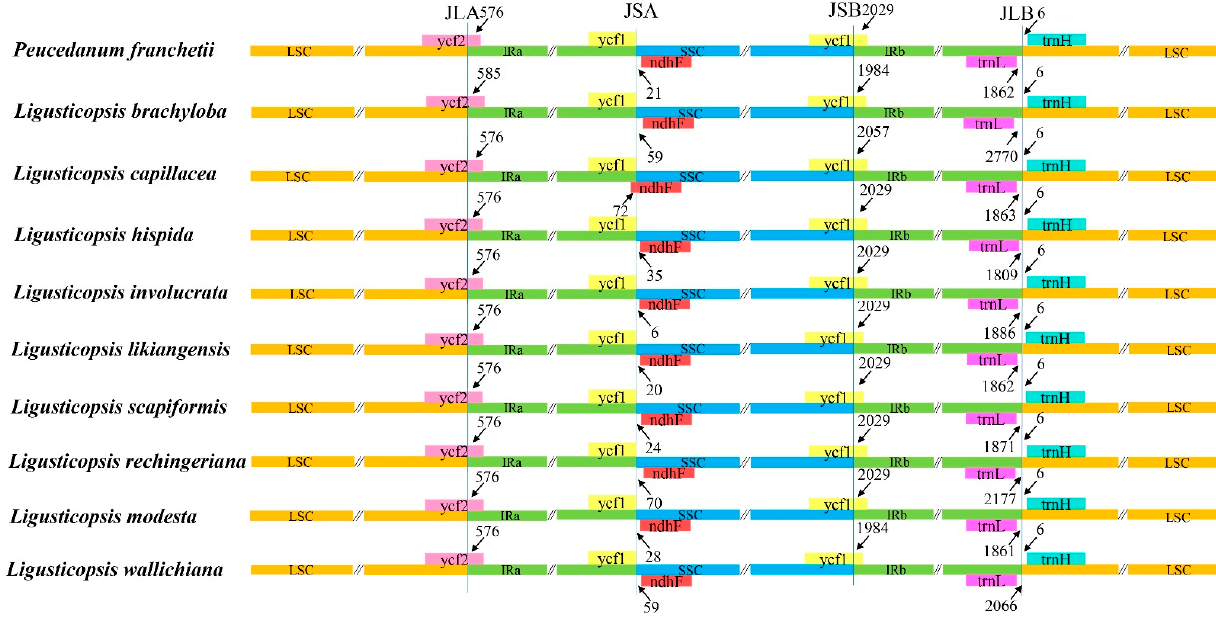
Figure 6. Comparison of the border positions of LSC, SSC, and IR regions across the ten plastomes. Functional genes and truncated fragments are denoted by colored boxes. The sizes of gene fragments located at boundaries are indicated by the base pair lengths.